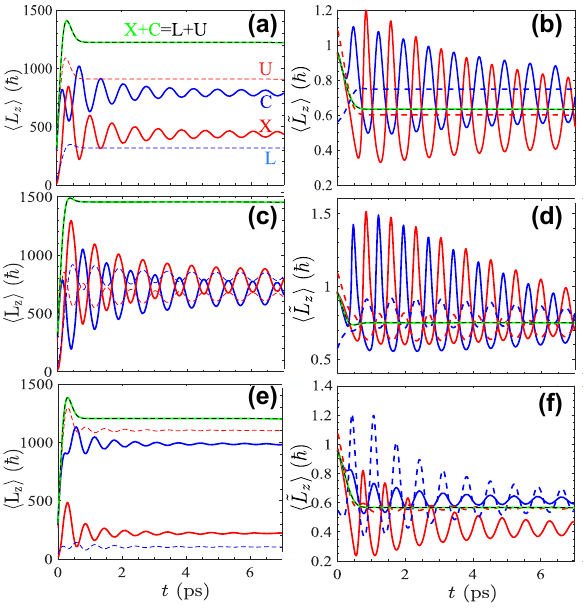
Figure 6: Time-varying orbital angular